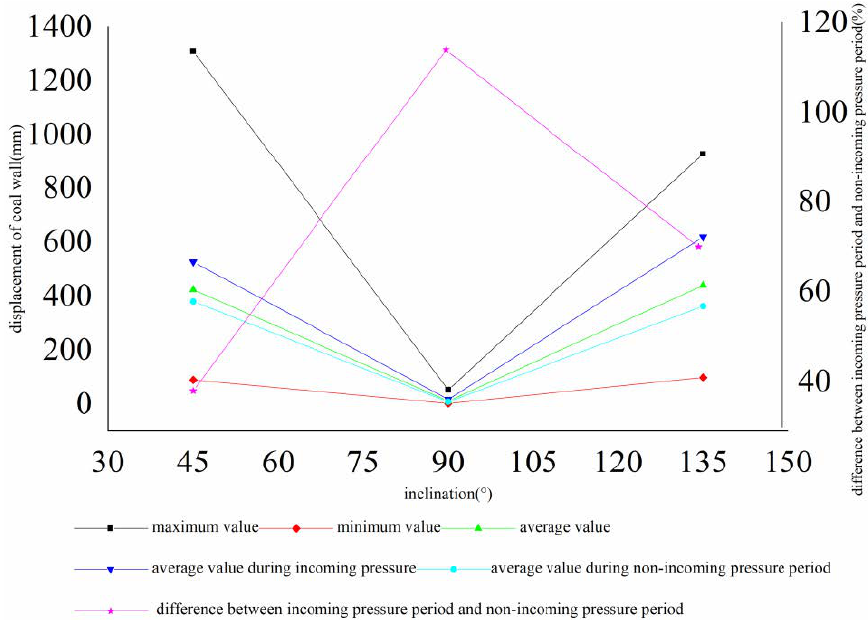
Figure 17. Coal wall Y-displacement change law with the joint inclination angle.